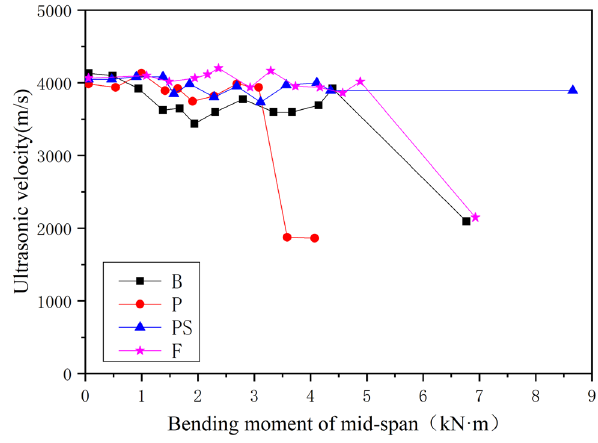
Figure 10: Relationship between bending moment of mid - span and ultrasonic